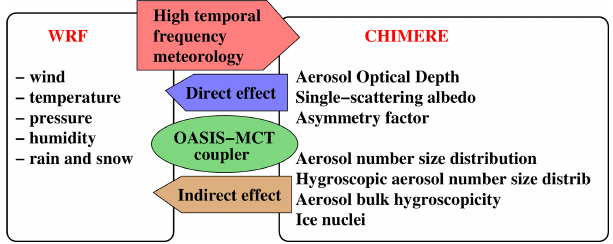
Figure 7. Main principle of the coupling between WRF and CHIMERE for the calculation of the direct and indirect effects of aerosols on